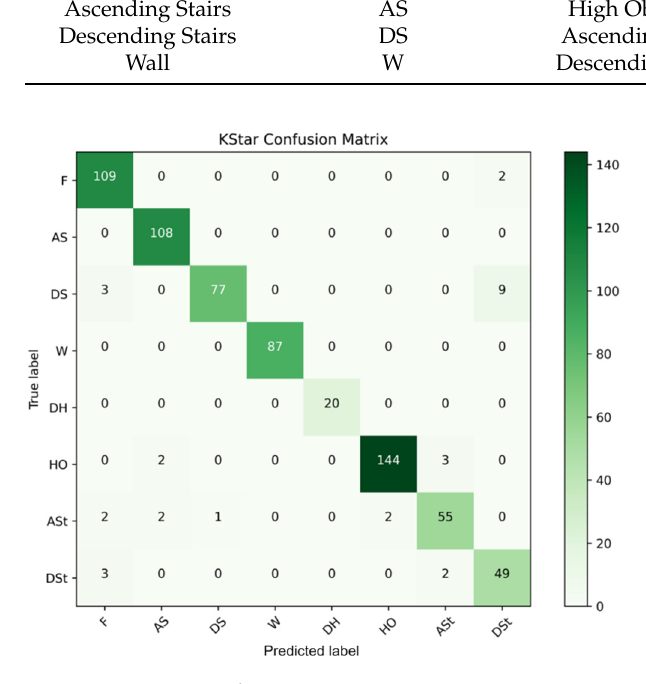
Figure 19. KStar Confusion Matrix using DS1.